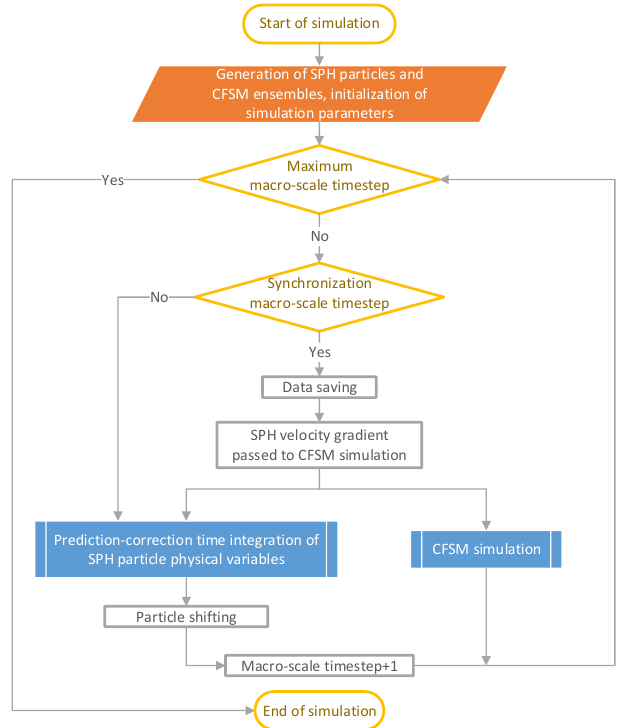
Figure 1. The flowchart of the multiscale simulation